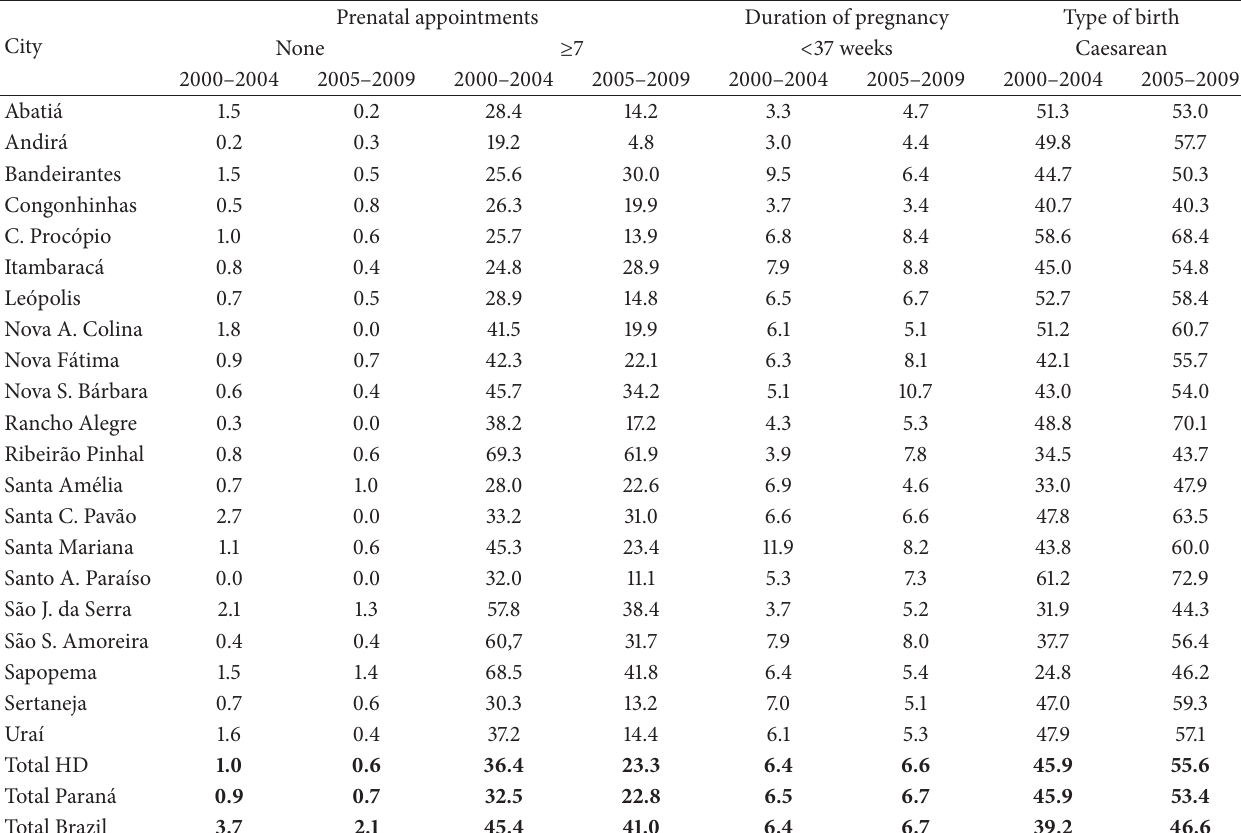
Table 3: Distribution of percentage means according to pregnancy variables, 18th HD, Paran´a, from 2000 to 2004 and 2005 to 2009. Prenatal appointments Duration of City